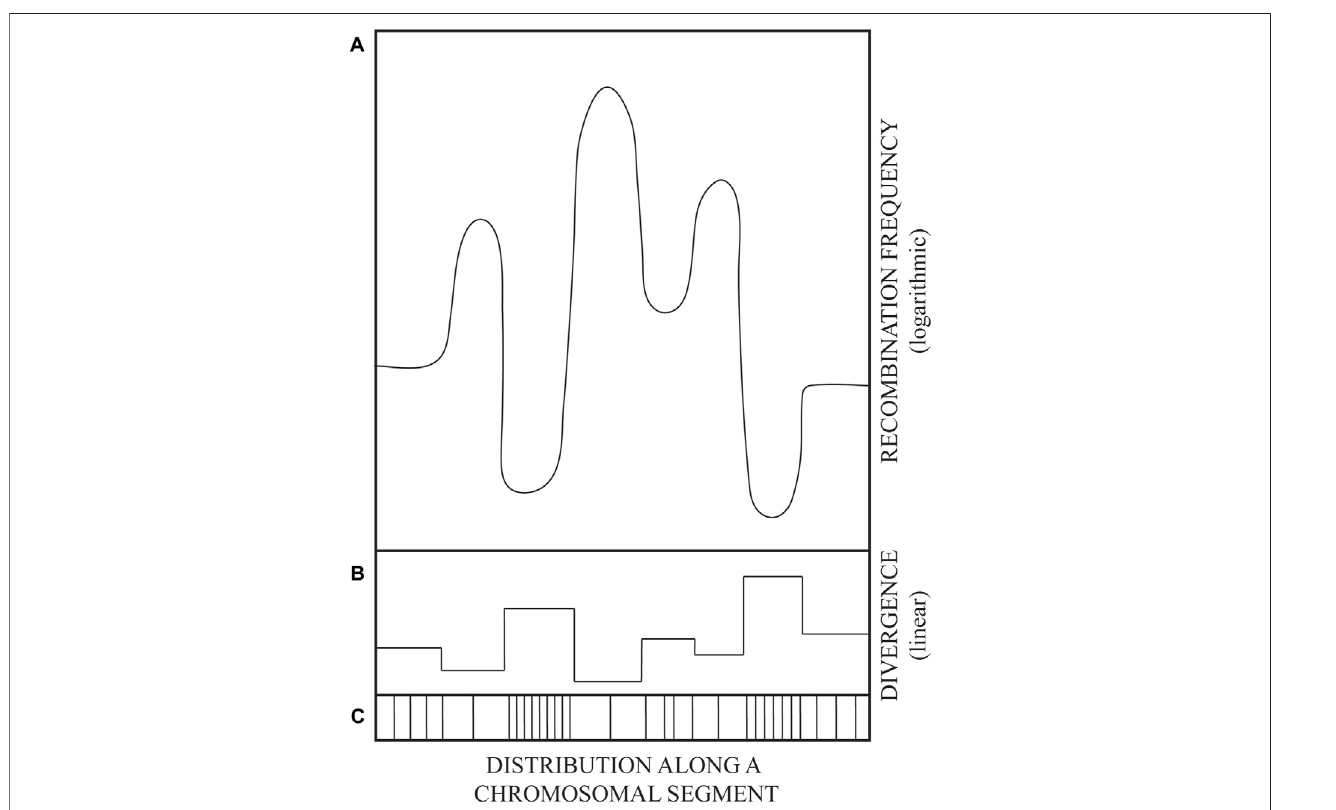
FIGURE 1 | A drawing illustrating the variation in parental DNA sequence divergence (linear scale) and the corresponding variation in recombination frequencies (logarithmicscale). SchematizedmirrorimageofDNAsequence divergence (B) ,recombinationfrequency (A) ,andthedistribution ofpolymorphism(mutations) alongan evolutionarily related genome segment (C) . Sketched from data in fi gures 4 and 5 of (Martinsohn et al., 2008). See also main text.